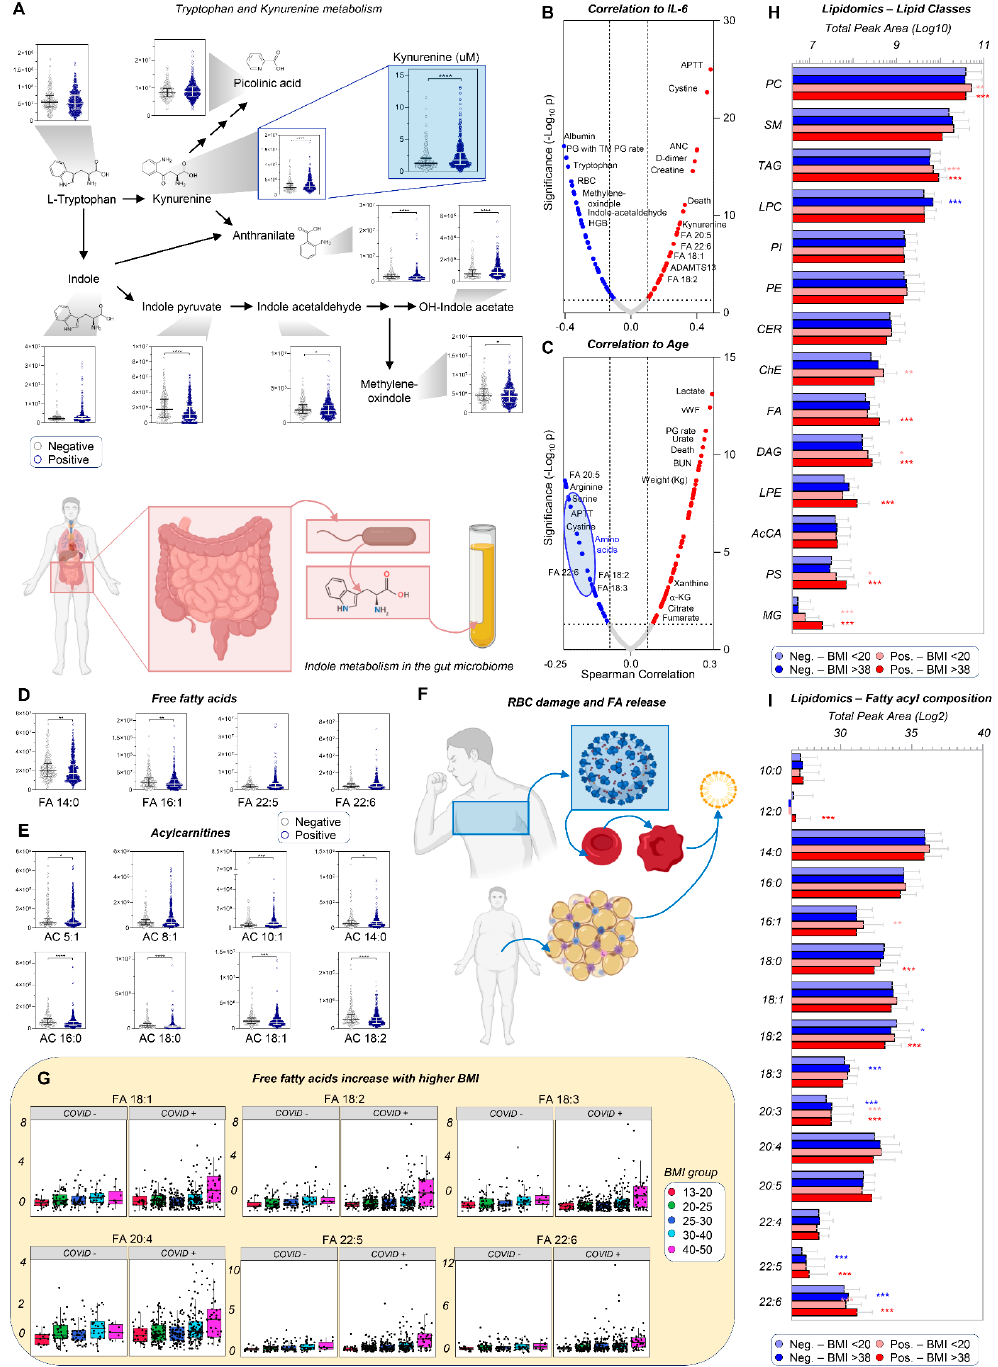
Figure 2. Alteration of tryptophan/kynurenine/indole metabolism as a function of inflammation, and dysregulation of lipid metabolism as a function of body mass index in hospitalized patients with and without COVID-19. In ( A ), violin plot of tryptophan metabolism as a function of COVID status (median + range). Metabolic and clinical correlates to interleukin 6 (IL-6) as a marker of inflammation ( B ) and patient age ( C ) indicate a strong correlation of this pathway and lipid metabolism, especially free fatty acids ( D ) and acylcarnitines ( E ), with disease state. Free fatty acids may derive from blood cell vesiculation and/or mobilization from white adipose tissue, a process that could fuel viral membrane formation ( F ). In ( G ), breakdown of free fatty acid levels as a function of patients’ body mass index (BMI) and COVID-19 status. Lipidomics analyses of COVID-19-positive and -negative patients with BMI lower than 20 or higher than 38 revealed a significant impact of these variables on lipid class ( H ) and fatty acyl composition ( I ). ( p < 0.05; * p < 0.01; ** p < 0.001; *** p < 0.0001; **** p <